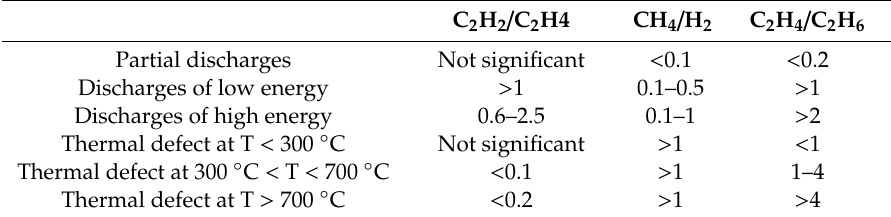
Table 2. Defect types recognized in the ratio method as per IEC 60599 Standard [22].